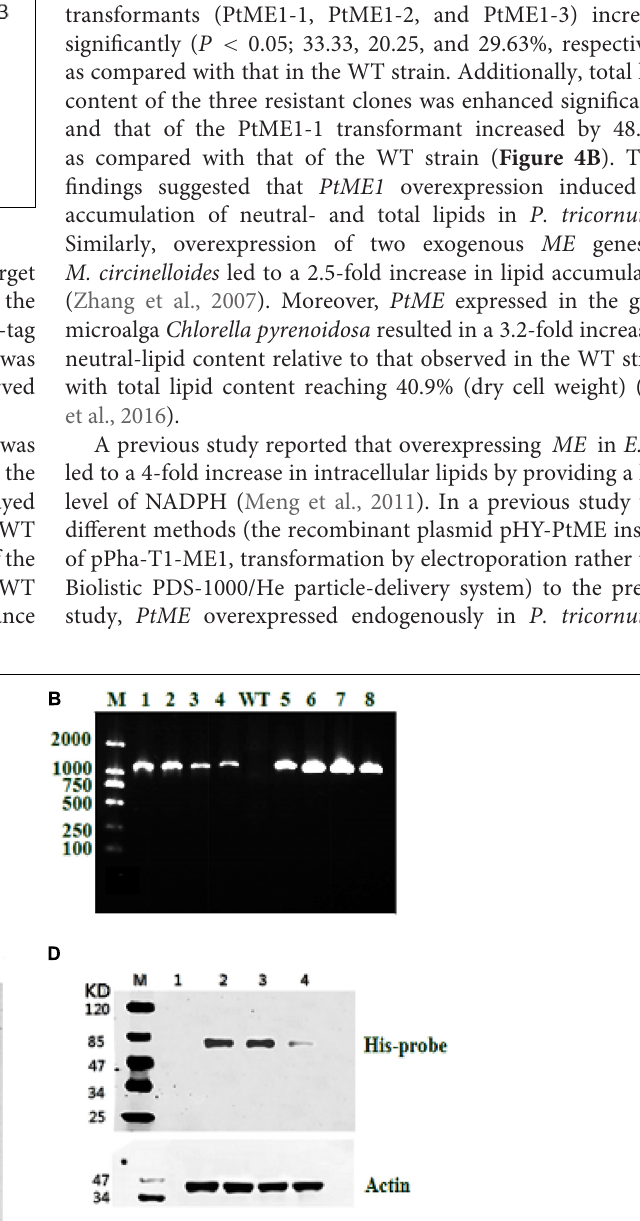
Frontiers in Plant Science |